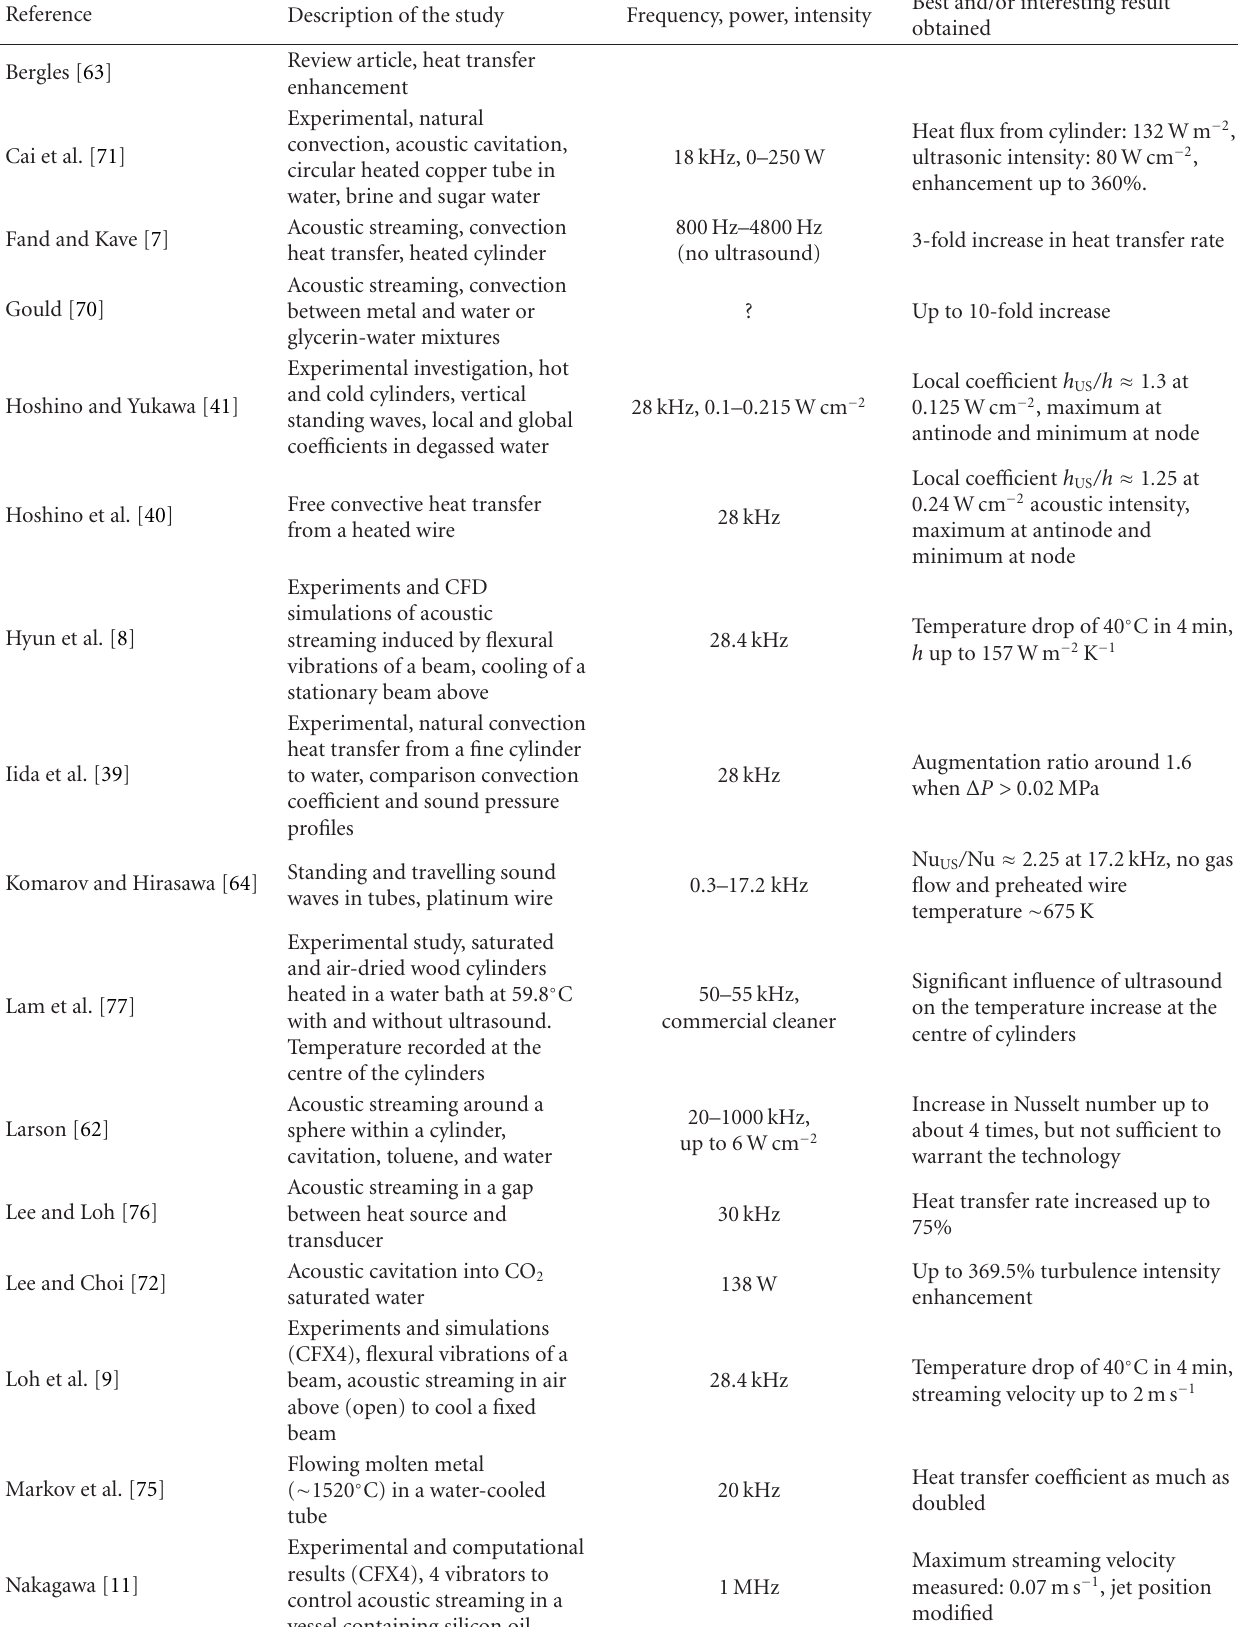
Table 4: Ultrasonic waves and convection heat transfer